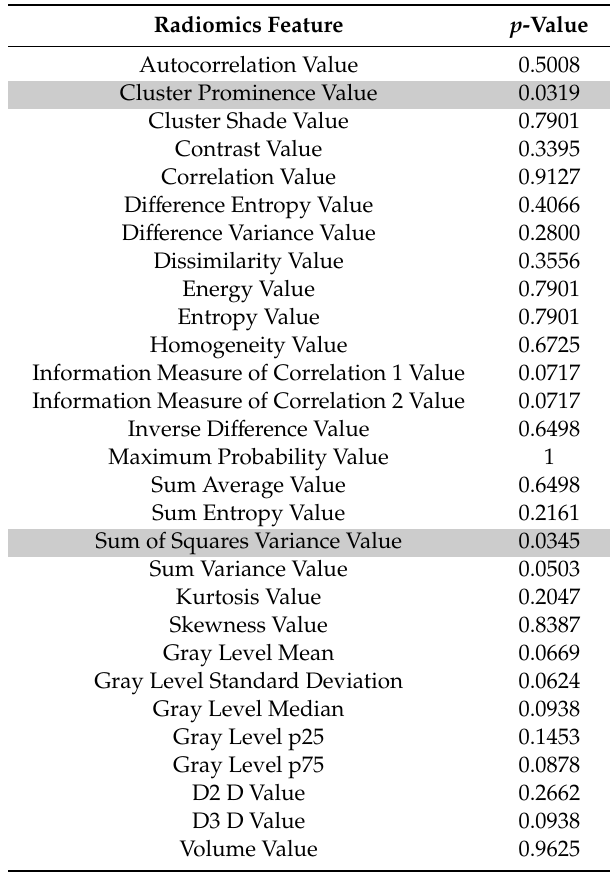
Table 4. Values of MR radiomics features of Warthin tumors versus malignant